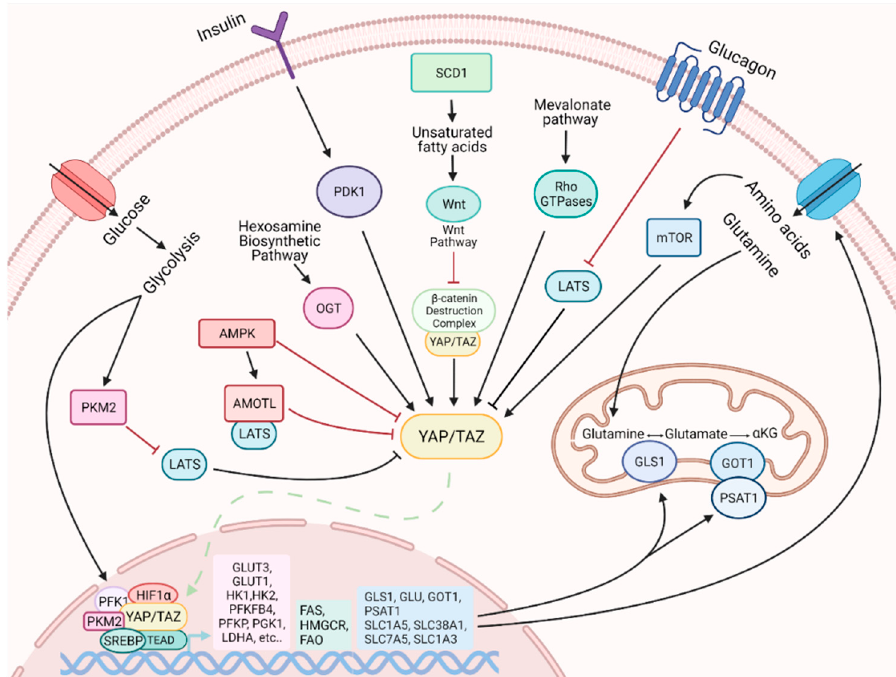
Figure 2. The activity of YAP/TAZ is influenced by various metabolic cues. Some of them can activate YAP and TAZ, such as high levels of glucose, the monosaturated fatty acid biosynthetic pathway and the mevalonate pathway, IIGF signaling and mTOR. Some others, like low glucose condition and glucagon stimulation, act by inactivating YAP/TAZ. YAP and TAZ, in turn, influence cell metabolism in various ways (see the text for more details). See the text for abbreviations.